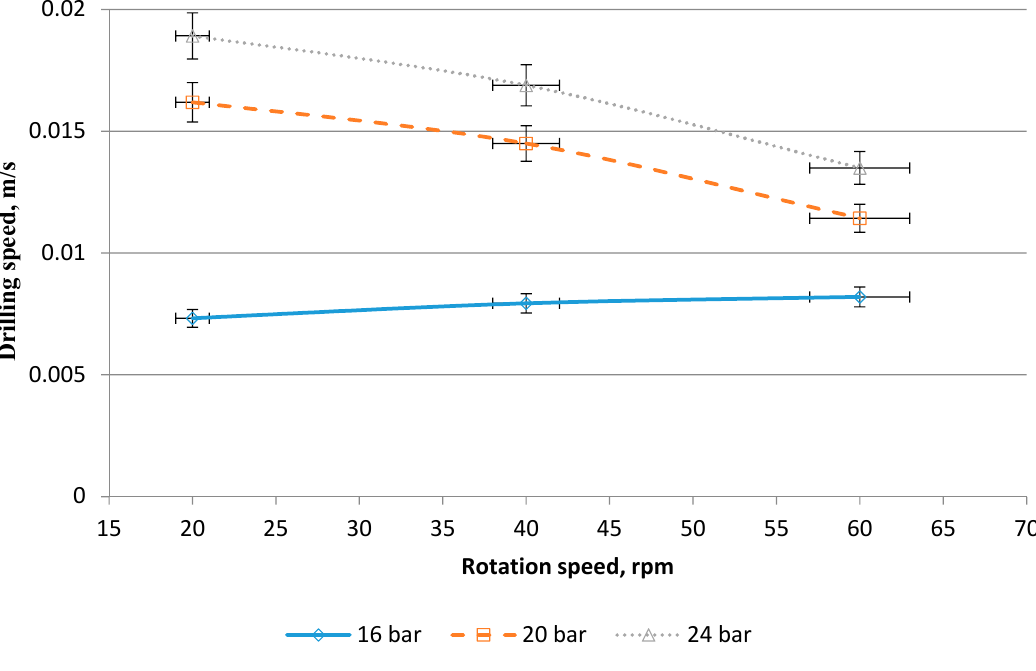
Figure 7. Variation of drilling velocity with rotation speed for several pressures (shown in the legend below the figure), for the 110 mm diameter drill bit, an interval of 90 to 108 m below the ground level, and boreholes 1–3.